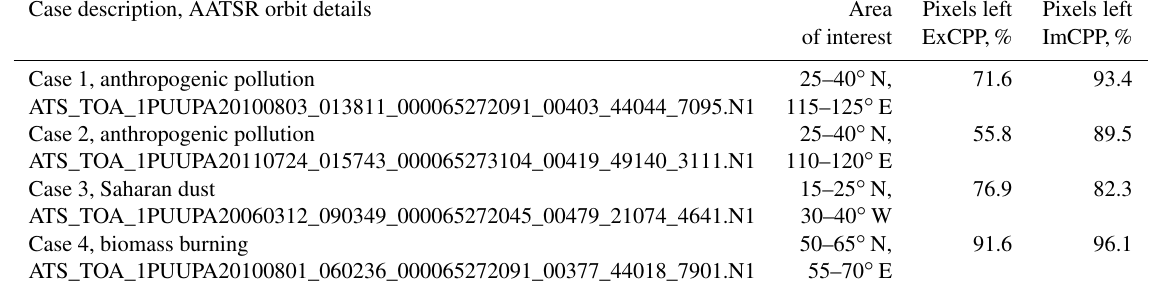
Table 1. Number of pixels left (compared to number of ADV/ASV-retrieved pixels) after the application of the existing CPP and the improved CPP for different cases, see Fig. 7. For orbit details, in ATS_TOA_1PUUPAyyyymmdd_hhmiss_000065272091_00403_nnnnn_7095.N1, yyyy is year, mm is month, d is day, h is hour, min is minute, s is seconds, nnnnn is the ENVISAT orbit number.